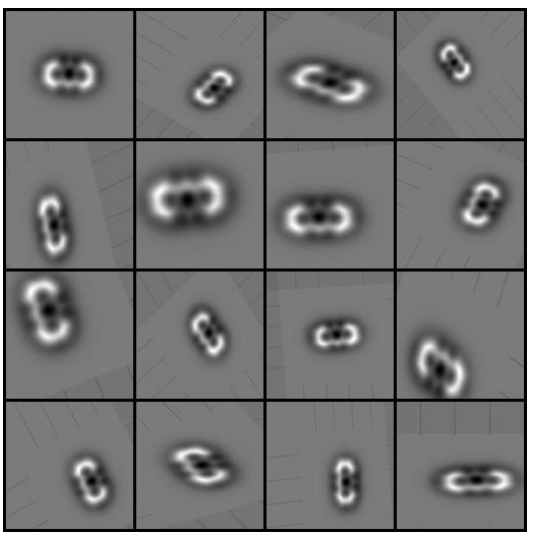
Figure A1. Top-left image is a theoretical simulation of the AFM image of acridine calculated with the approximate version of the FDBM model implemented in the latest release of the PPM. The remaining images are examples of random deformations of this theoretical AFM image generated by the image data generator (IDG). These deformations can include rotations, flip, zoom, shear, and shift of the image, or a combination of them. The selection of the deformation parameters is randomized for each theoretical image at each training epoch in order to add variation to the data used for the training and avoid